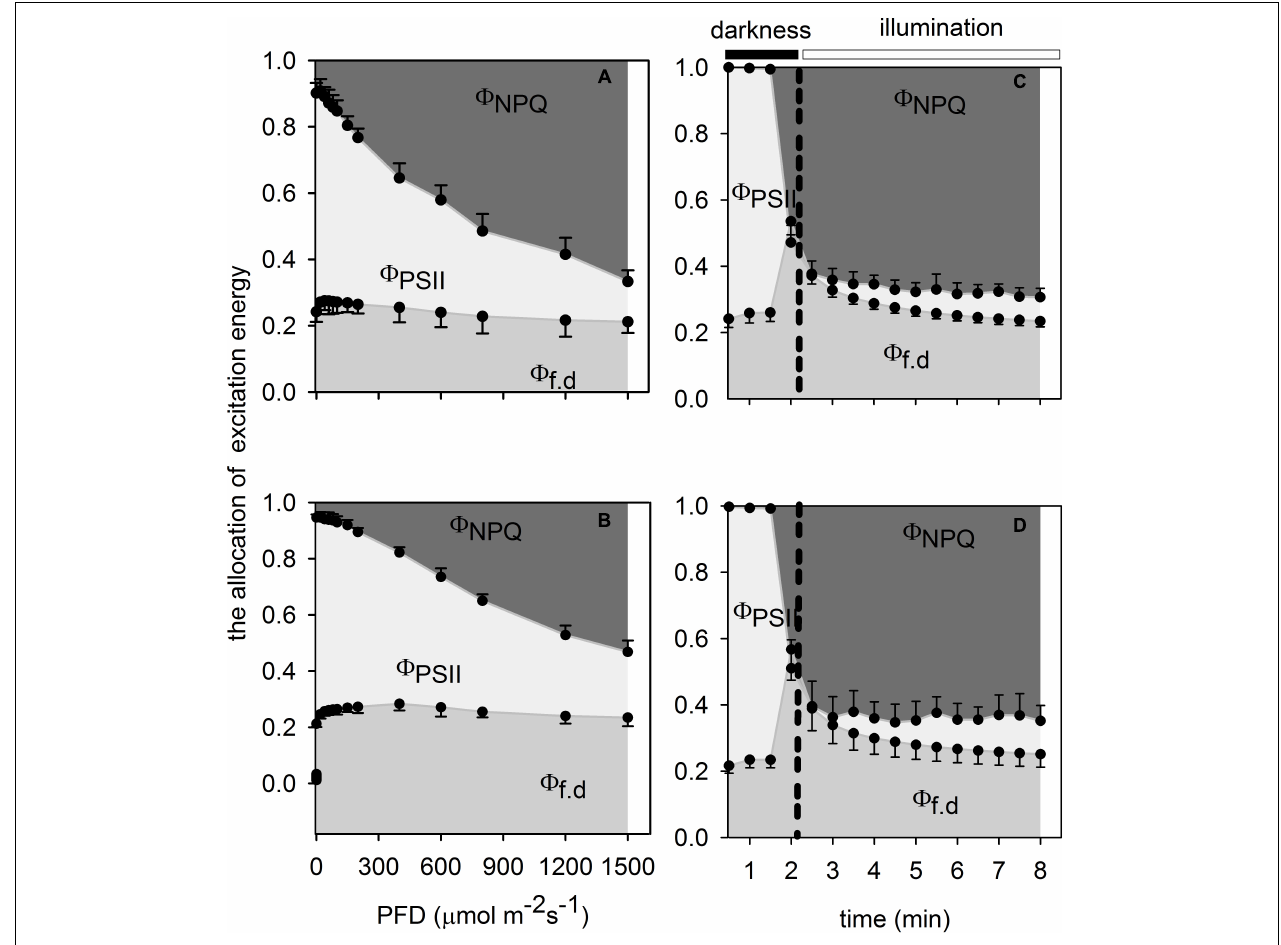
FIGURE 5 | Effects of photon flux density (A,B) and the simulated sunfleck (C,D) on the energy allocation pattern in the leaves of A. xiei under different cropping system: monoculture (A,C) and intercropping (B,D) . (cid:56) NPQ : the fraction of absorbed light energy lost to light-dependent thermal dissipation, (cid:56) PSII : the fraction of absorbed light energy lost to photochemistry of PSII, and (cid:56) f , d : the fraction of absorbed light energy lost to fluorescence and constitutive thermal dissipation. Each point is the mean ± SD of five